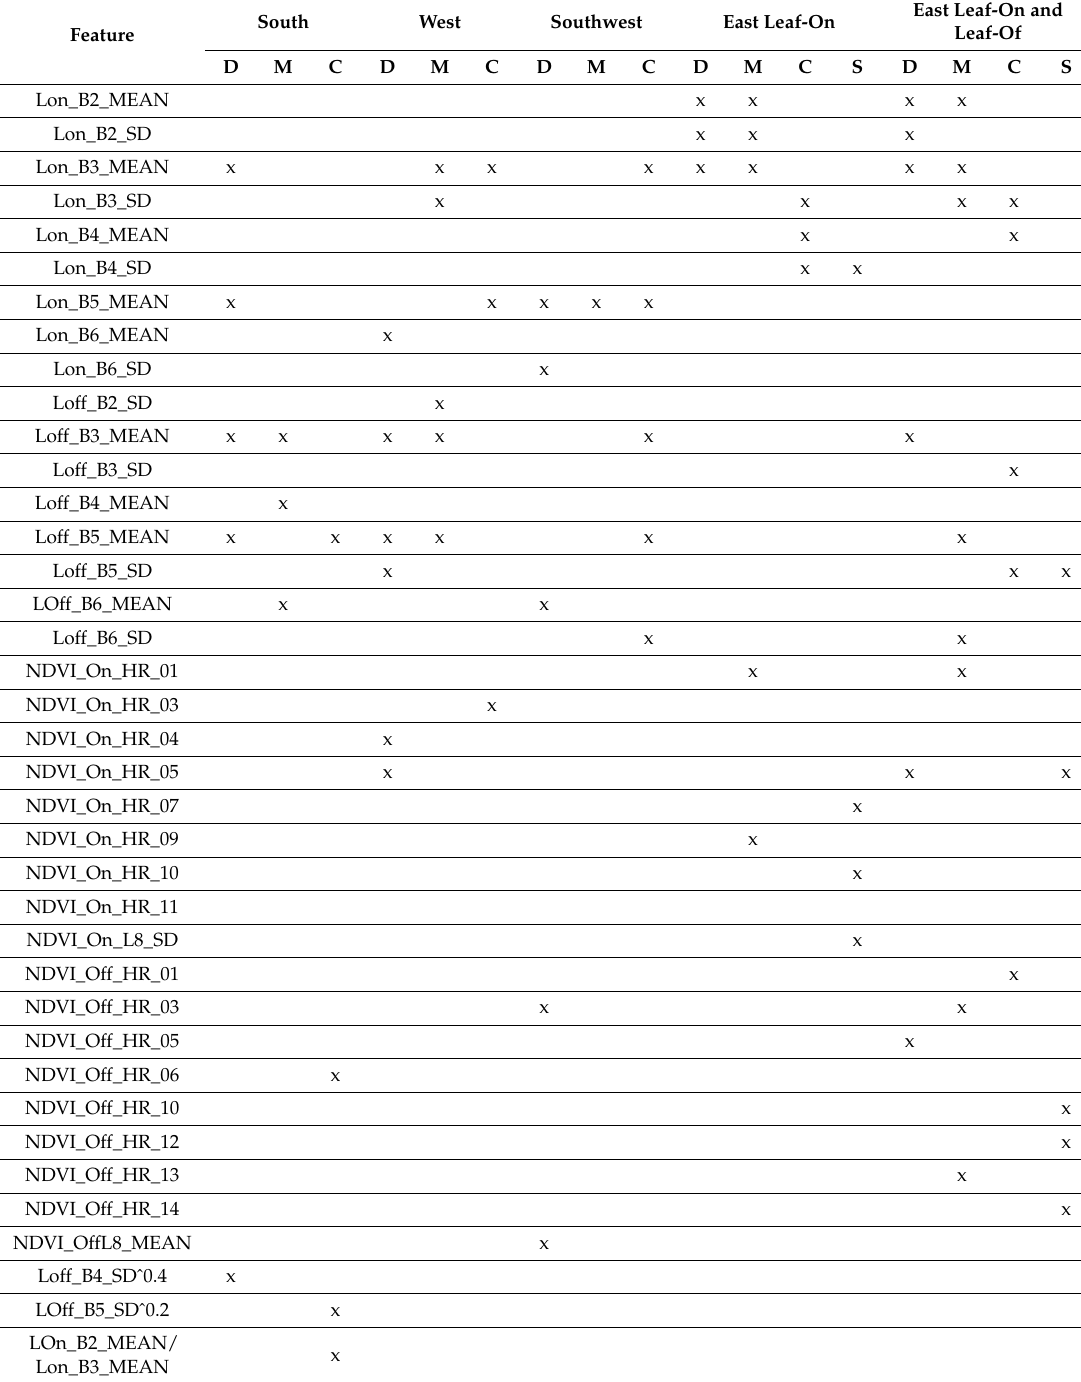
Table A1. List of satellite image features used for respective areas and forest types. D = deciduous, M = mixed coniferous, C = coniferous, S =